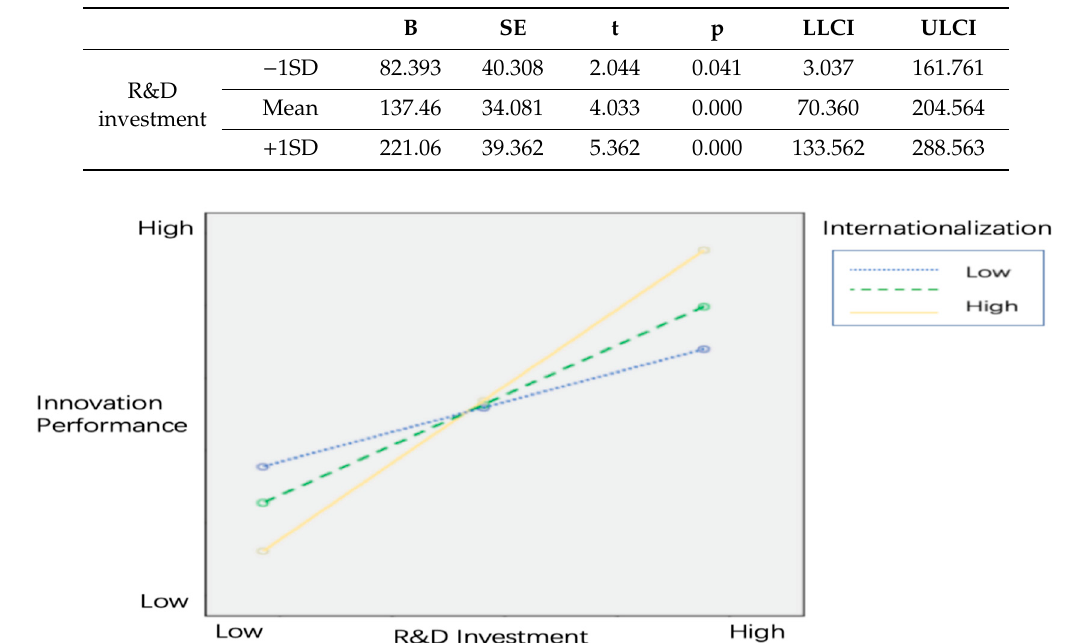
Figure 3. The interaction between R&D Investment and Internationalization.